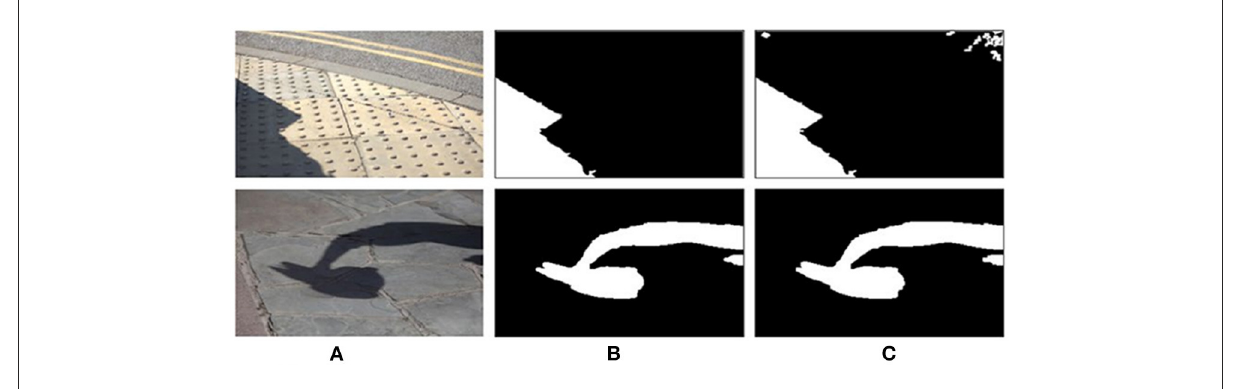
FIGURE8 (A–C) Datasets for network training.